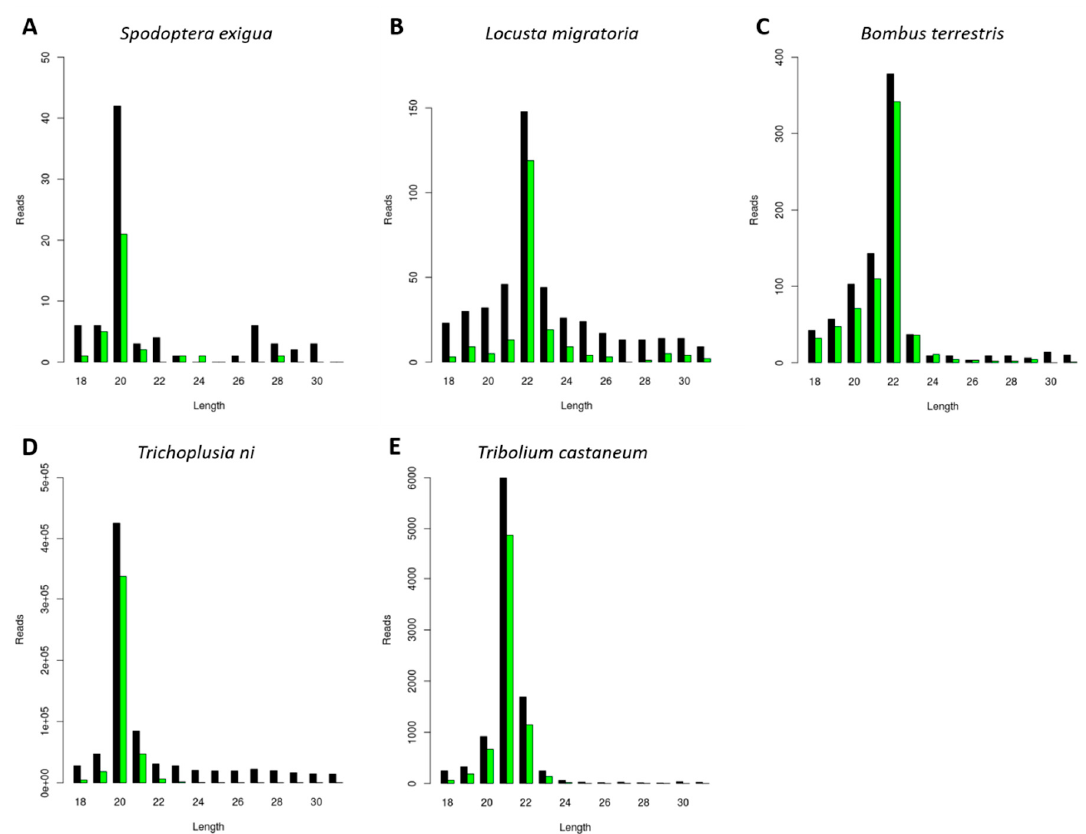
Figure 1. Generation of Cricket Paralysis Virus (CrPV)-derived small interfering RNAs (siRNAs) with species-dependent length distribution. Length distribution of small RNAs mapping to CrPV, derived from fat body of CrPV-infected Spodoptera exigua ( A ), Locusta migratoria ( B ), and Bombus terrestris ( C ); as well as from CrPV-infected Trichoplusia ni High Five cells ( D ) and Tribolium castaneum TcA cells ( E ). Reads ( y axis): number of reads. Length ( x axis): length (nt) of the reads. Black: sense reads. Green: antisense reads. To avoid degradation products and general contaminants, reads shorter than 18 nt and longer than 31 nt were not included. Mapping was performed with Bowtie2 and graphs were obtained with the viRome package in R.